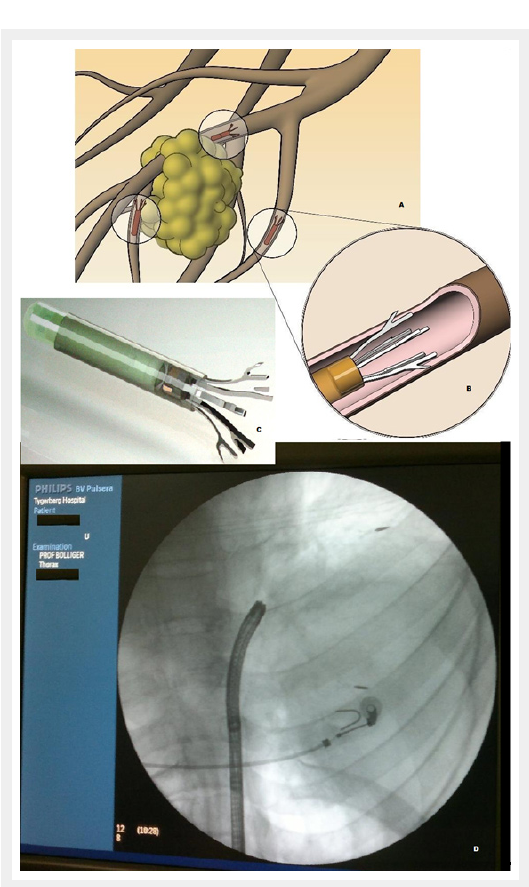
A- Schematic representation of Anchored Beacon® Transponders in situ around the tumor; note: each transponder is deployed in a separate airway; B- Magnified view of the distal end of a transponder showing anchorage in a bronchus; C- The actual Anchored Transponder, approximately the size of a grain of rice; D- Fluoroscopic view of the anchored transponders in situ. In a large right sided lung cancer two out of three transponders have been deployed, one just distal to the ECG electrode, the second one at the distal tumour adjacent to normally aerated